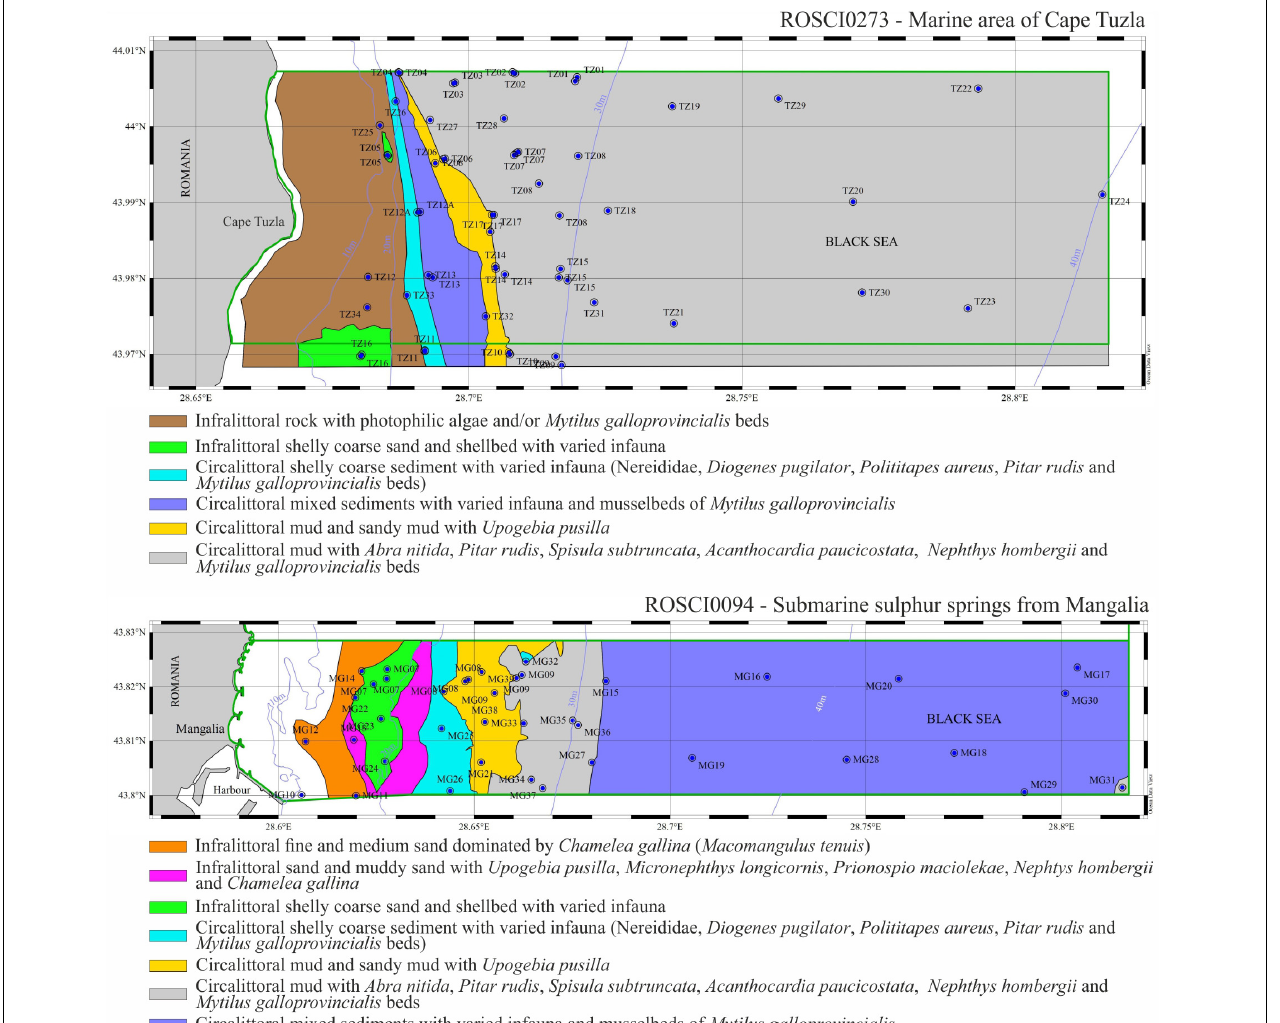
FIGURE 5 | Maps of distribution of six benthic habitats in the ROSCI273 Cape Tuzla and seven in the ROSCI0094 Mangalia submarine sulfur springs, classified according to their sedimentological and faunistic features, based on the Romanian Broad Habitat Types (see section “Materials and Methods” for details). Purple lines are depth contours whereas green lines identify the limits of the